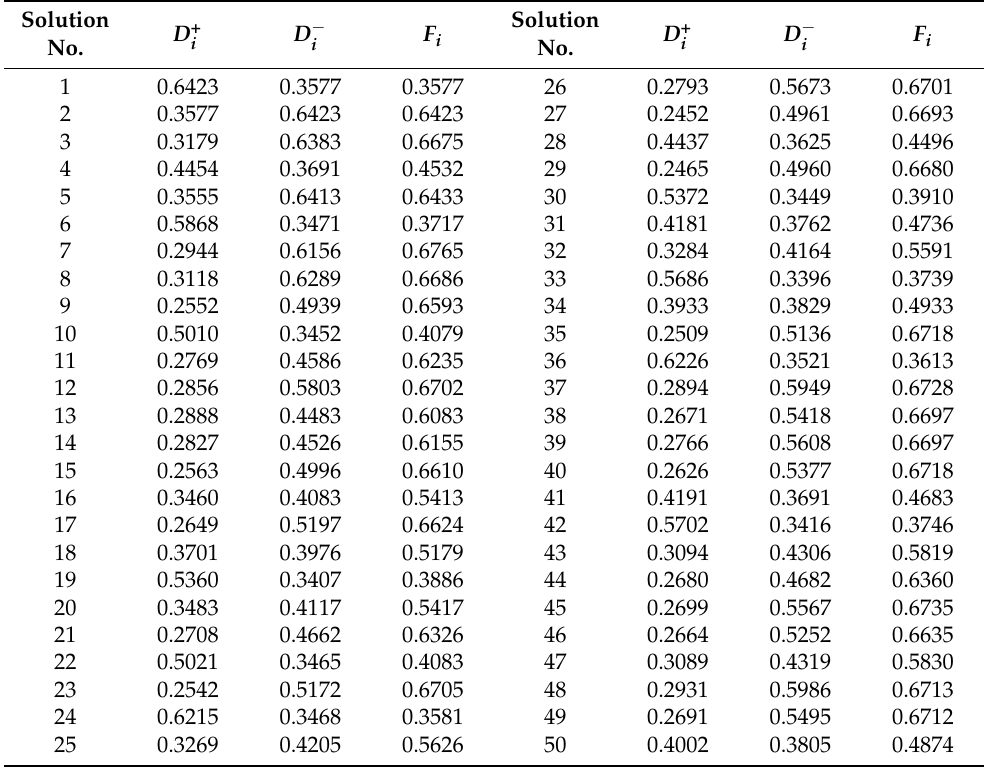
Table 4. The Euclidean distance and closeness of